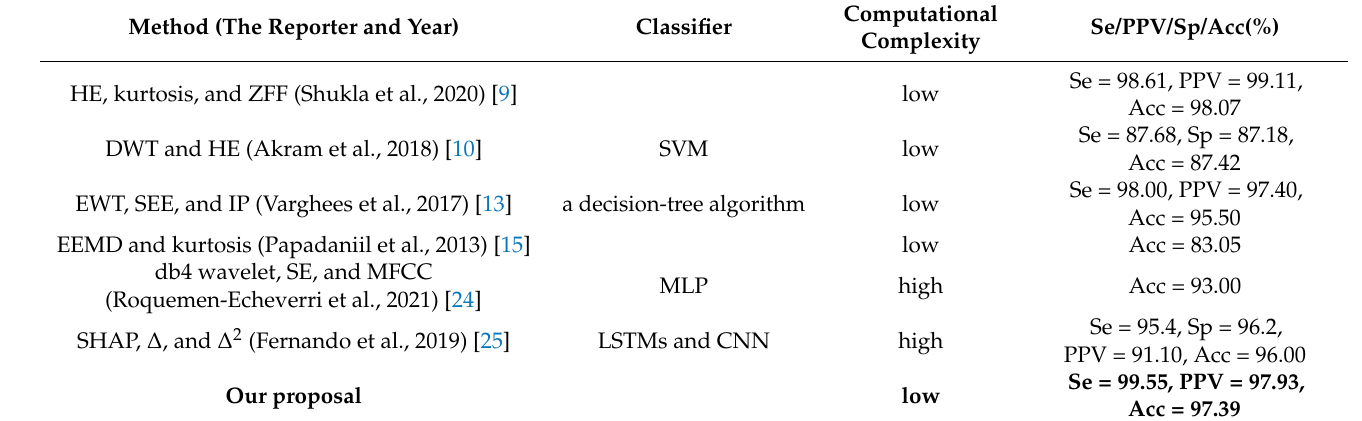
Table 2. Comparison of different algorithms for heart sound segmentation.